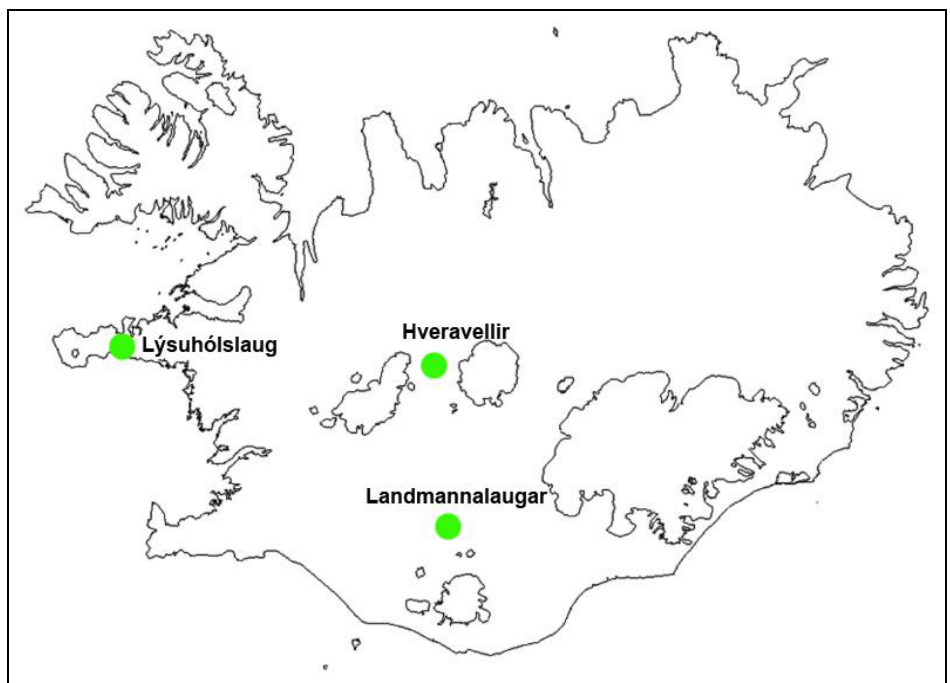
Figure 1. Locations of the study areas in